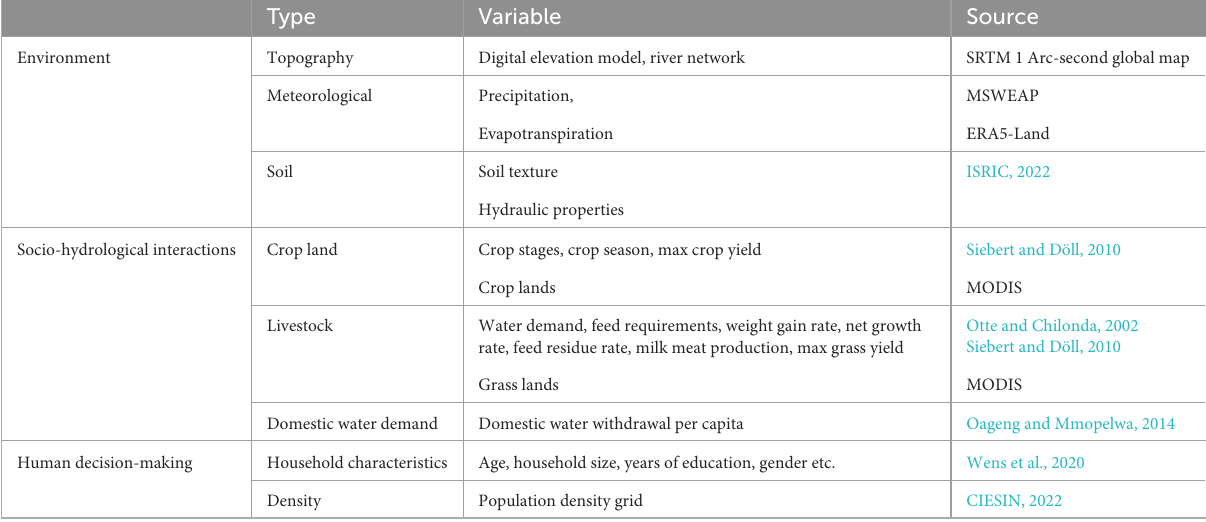
TABLE 2 Data input for the different components of the ADOPT-AP model.